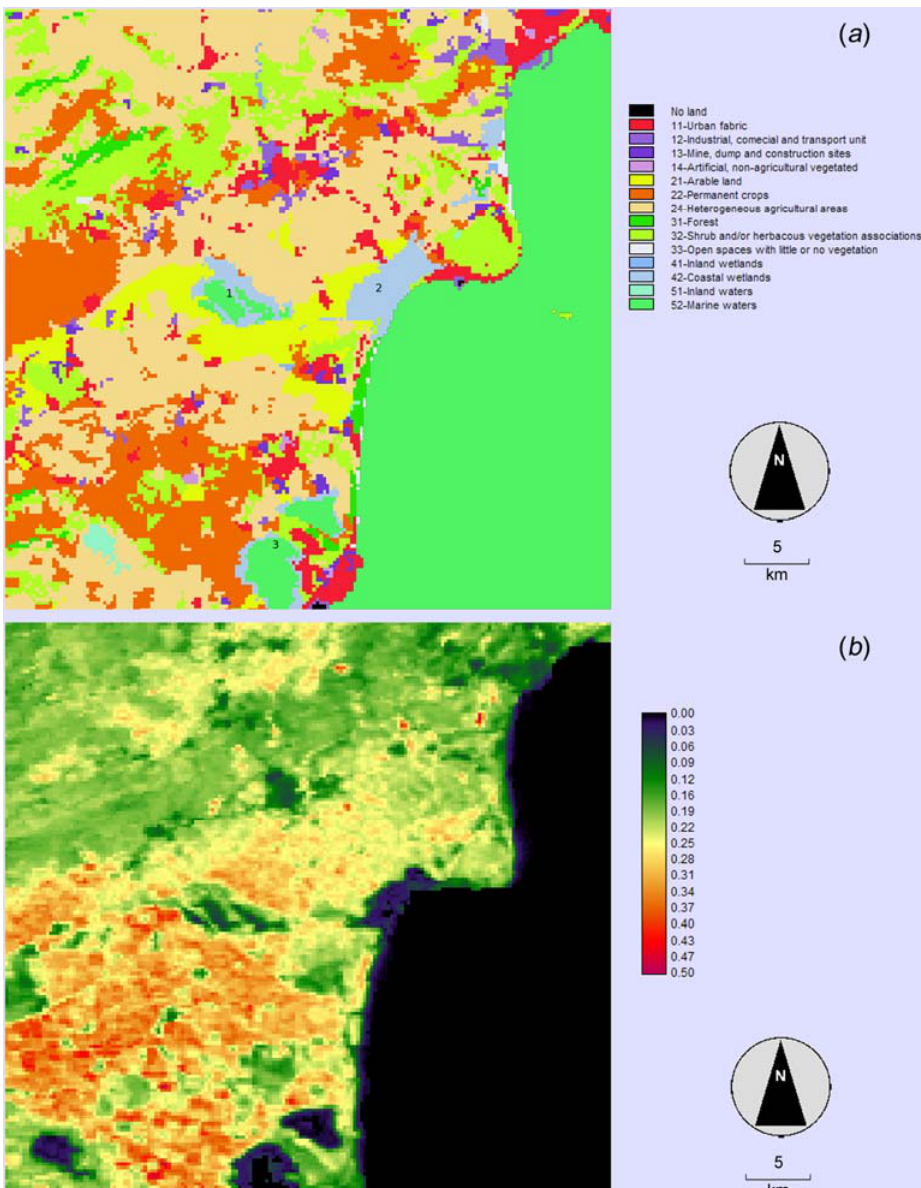
Figure 1. Regional analysis maps composition of: (a) CORINE Land Cover Level II land-covers map of the study area; (b) average EVI values for the studied period. Numbers in the land-use map correspond with: (1) the Natural Park of El Hondo; (2) the Natural Park of Salinas de Santa Pola; and (3) the Natural Park of Salinas de la